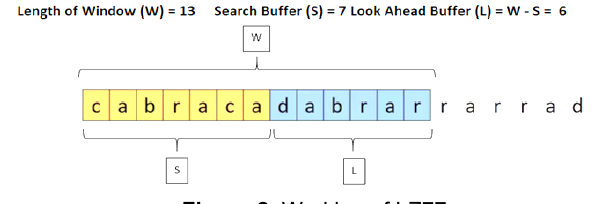
Figure 2. Working of